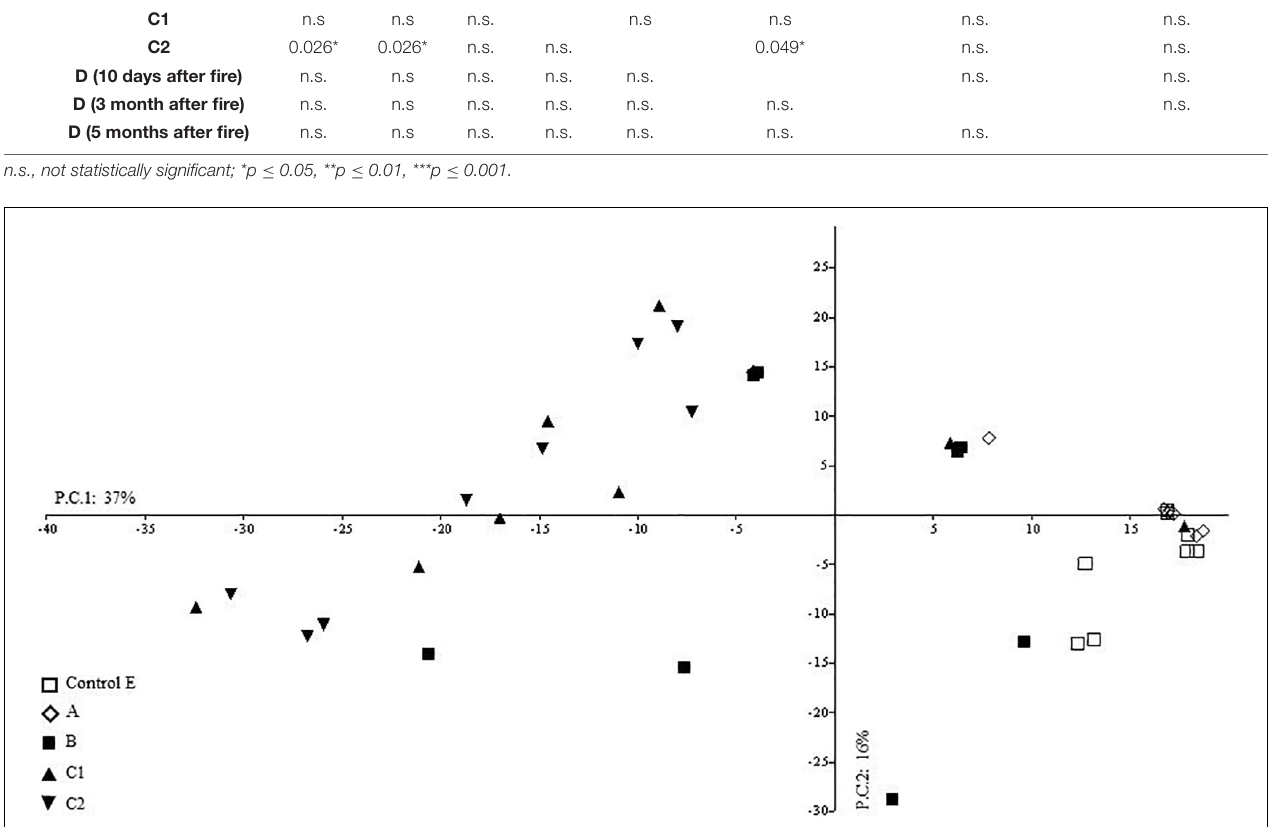
and Diplopoda ( Figure 9 ) while PC2 (25% of total variance)